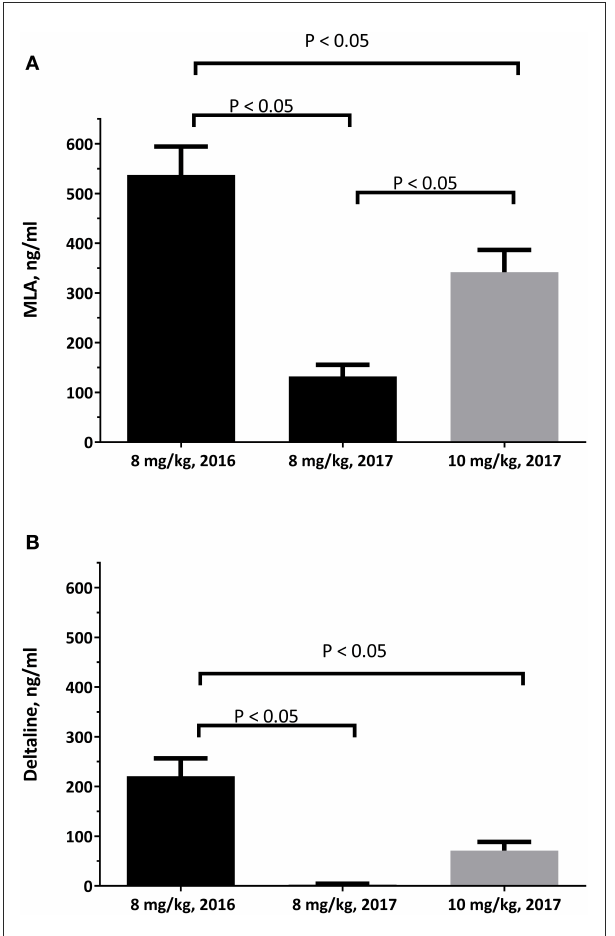
FIGURE3 The serum concentrations of deltaline (A) and MLA (B) in 10 Angus steers at 24 hours after oral dosing. The serum samples were obtained just prior to the cattle being exercised during haltering and analyzed as described by Welch et al. (43). Statistical comparisons were made by ANOVA and Tukey’s multiple comparisons test.